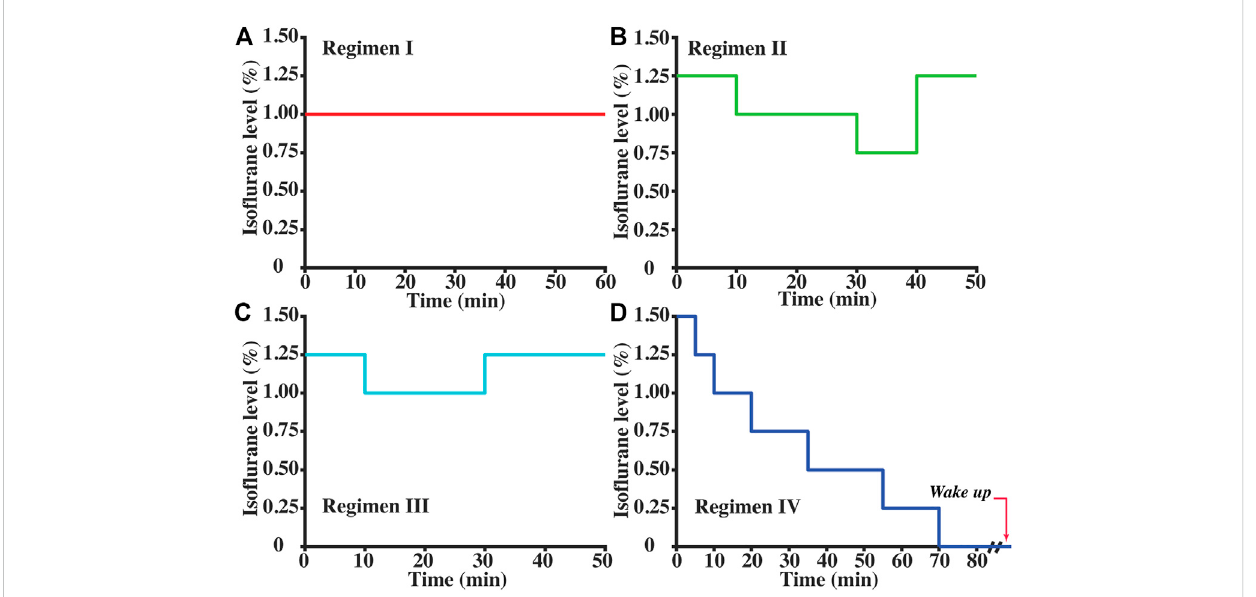
Anesthetic regimens to explore the relationships between CBF and other basic parameters (iso fl urane dose, exposure time to anesthetic regimen, respiration rate, and heart rate): (A) Regimen I (N = 5); (B) Regimen II (N = 4); (C) Regimen III (N = 4); and (D) Regimen IV (N = 6). Iso fl urane was delivered with medical air (21% oxygen) at 0.5 L/min.